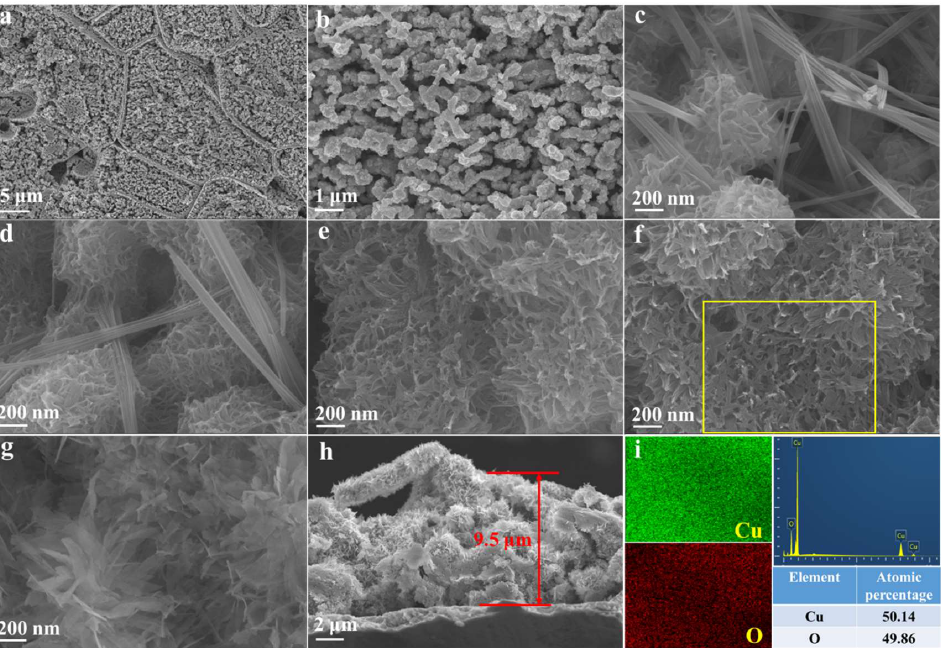
Figure 3. SEM surface view of ( a , b ) dealloyed Cu foil, ( c – h ) after electrooxidation for 15 min, 30 min, 1 h, 2 h, and 5 h, respectively; SEM cross-section view of ( h ) dealloyed Cu foil after electrooxidation for 2 h; ( i ) EDX mapping and spectrum corresponding the yellow rectangle area in ( f ). TEM and HRTEM were conducted to probe the microstructural features of O-Cu- 15m and O-Cu-2h. Corresponding to the SEM results, nanobelts and nanoflakes are ob- served from O-Cu-15m (Figure 4a). The nanobelts are 10–30 nm in width. From the HRTEM result in Figure 4b, we observe two lattice distances, corresponding to (11 1(cid:3364) ) lat- tice plane from CuO and (111) lattice plane from Cu 2 O, respectively. The same lattice planes are also found in the nanoflakes (Figure 4c), indicating that both Cu 2 O and CuO generated during electrooxidation. For the O-Cu-2h sample, the lattice planes observed from one typical flake indicat e the co-exitance of the CuO (002) and Cu 2 O (200) planes (Figure 4d,e). Another nanoflake shows the lattice plane from CuO (002) and Cu 2 O (111) (Figure 4f). The HRTEM analyses prove the formation of CuO and Cu 2 O after electrooxi- dation, which agrees with the XRD results. In a previous study, pure CuO could be fabri- cated by anodizing the dealloyed nanoporous Cu at 15 mA cm –2 and then calcining at 200 °C for 2 h [18]. This work also obtained the mixture of CuO and Cu 2 O after one-step elec- trooxidation at a constant potential. The XPS results prove that more CuO generated with a longer oxidation time. The electrode is nominated as Cu x O/Cu electrode in the following section.